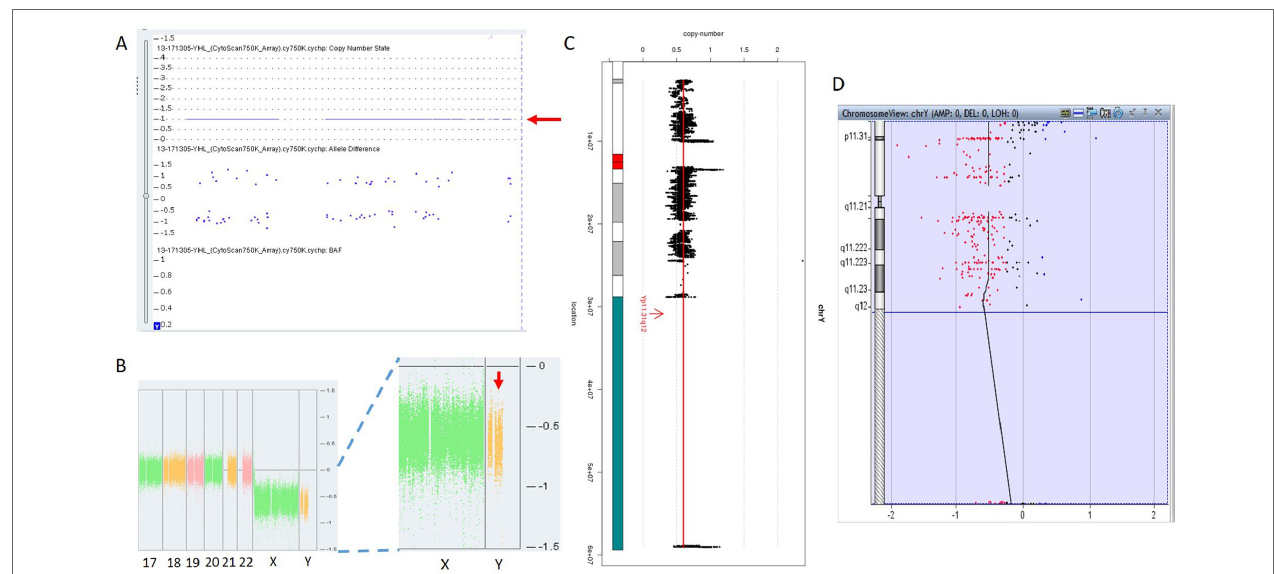
FIGURE 2 | Mosaic Turner syndrome detected by GS. In 17NT0005, CytoScan 750K CMA platform reported (A) a copy number as 1 for chromosome Y (indicated by a red arrow) and (B) apparently normal male fetus (partial figure of weighted Log2 ratio across each chromosome), although a slight decrease of Log2 ratio of chromosome Y was observed compared with the Log2 ratio of chromosome X (manifested by a red arrow). (C) GS reported a 40% decrease of the copy number of chromosome Y and confirmed by the aCGH CMA platform shown in (D) . In figure (C) , the copy ratio of each window is indicated by a black dot and the average copy ratio of chromosome Y is reflected by a red vertical line. Karyogram of chromosome Y is shown on the left. In figure (D) , dots in red, in black, and in blue indicate copy number lost, copy number neutral, and copy number gained, respectively. The average Log2 ratio is indicated by a black vertical